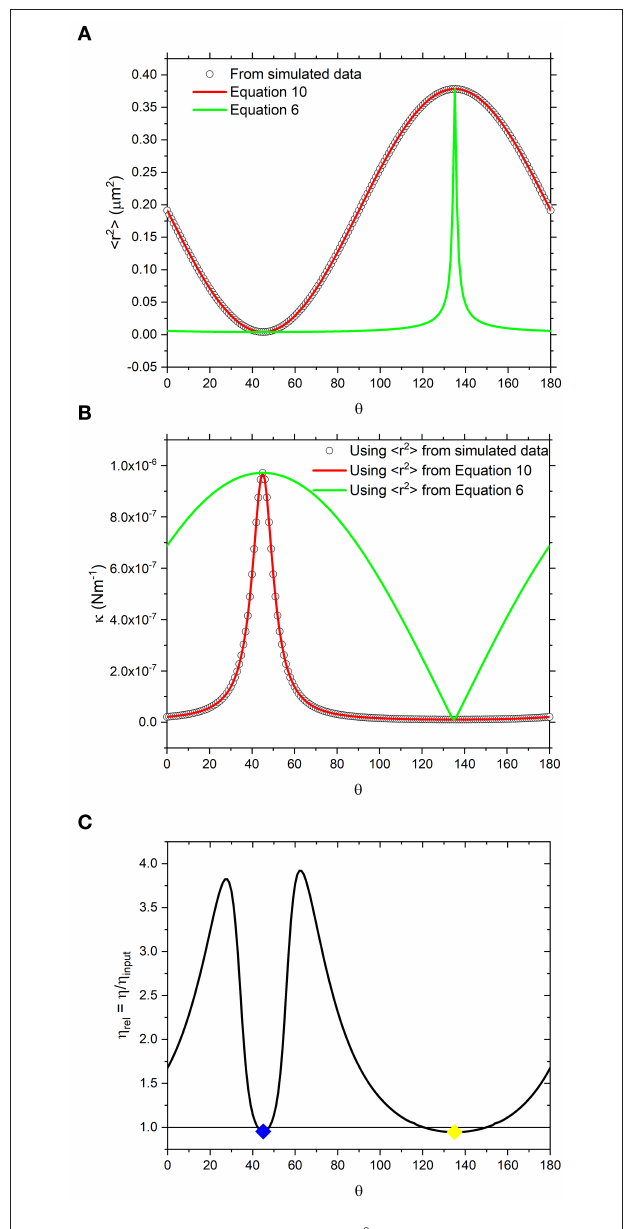
FIGURE 2 | (A) White circles are values of < r 2 > obtained directly from simulated data shown in Figure 1 , resampled at increments of 1 θ = 1 ◦ . Alongside are lines representing the values calculated using equation 10 which is derived from the trap geometry (red) and equation 6 which is derived from a vector analysis of the forces acting on the bead (green). (B) the same as (A) but using the < r 2 > values reported in a) to calculate κ using equation 3. (C) Relative viscosity values obtained by fitting NPAF plots to equation 1. Blue and yellow diamonds are the values of relative viscosity, calculated at 45 and 135 ◦ which are the axes along which < r 2 > is minimized and maximized,